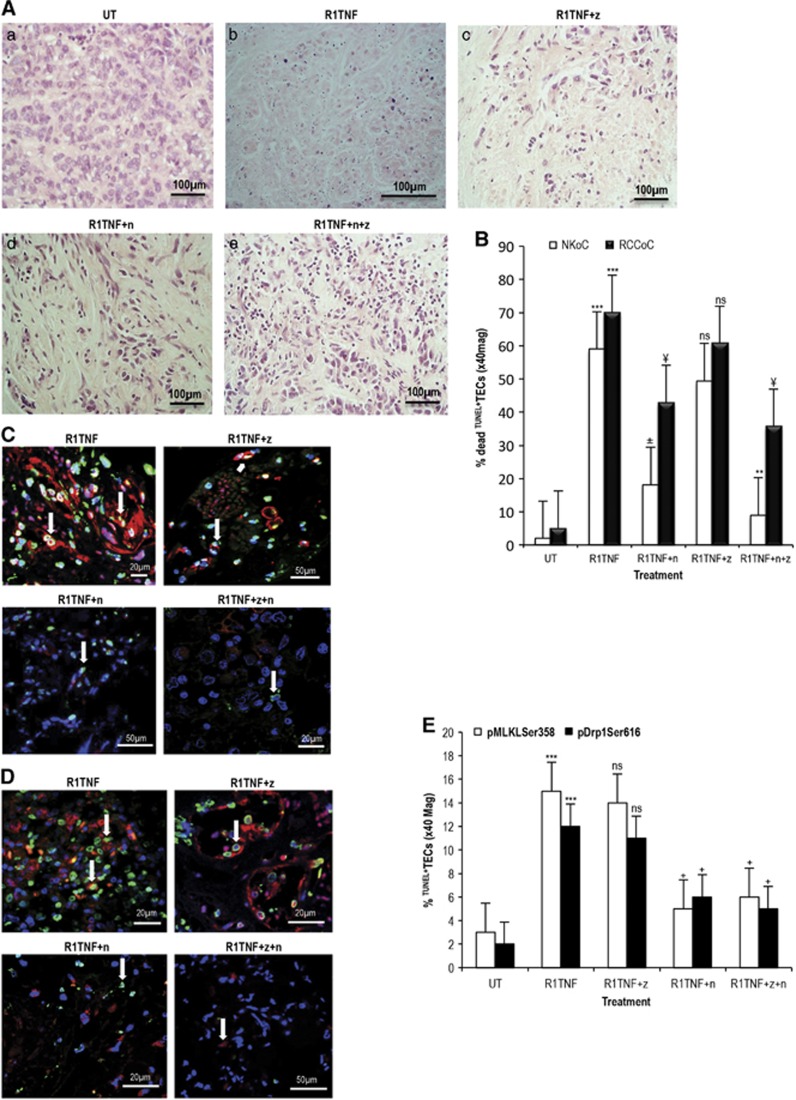
(A) Representative hematoxylin and eosin-stained sections demonstrate morphological features of necrosis in organ cultures of grade 1 ccRCC treated with or without necrostatin-1 or/and zVAD.fmk followed by R1TNF. R1TNF induced increased cell death compared with untreated (UT) cultures (a and b). Treatment with zVAD.fmk (z) (c) resulted in partial inhibition of cell death, further rescued by necrostatin-1 (n) (d), even more so by a combination of z and n (e). (B) Quantification of parallel sections stained with TUNEL show the precentage of dead tubular epithelial cells (TECs) in 10 random high power fields at × 40 magnification. ***P<0.0001 versus UT; **P<0.001 versus R1TNF+n (NKoC), ±P<0.01 versus R1TNF (NKoC), ¥P<0.05 versus R1TNF (RCCoC); ns, not significant. (C and D) R1TNF induced increased level of TUNEL+mTECs (green), also expressing pMLKLSer358 or pDrp1Ser616 (arrows) (red). Treatment with zVAD.fmk (z) partially reduced the number of TUNEL+mTECs (arrows) but did not have any effect on pMLKLSer358 or pDrp1Ser616 expression. In contrast, treatment with necrostatin-1 (n) resulted in a significant reduction in the number of TUNEL+mTECs, associated with a diminished level of pMLKLSer358 or pDrp1Ser616 comparable with cultures treated with a combination of zVAD.fmk and necrostatin-1 (z+n) (arrows). (E) Quantification of the percentage of TUNEL+mTECs in combination with pMLKLSer358 or pDrp1Ser616 in 10 random high power fields at × 40 magnification; ***P<0.001 versus UT; +P<0.05 versus R1TNF; ns, not significant. Bars=mean±S.E.M. Images are representative of n=3 independent experiments from six separate organ culture experiments with similar results